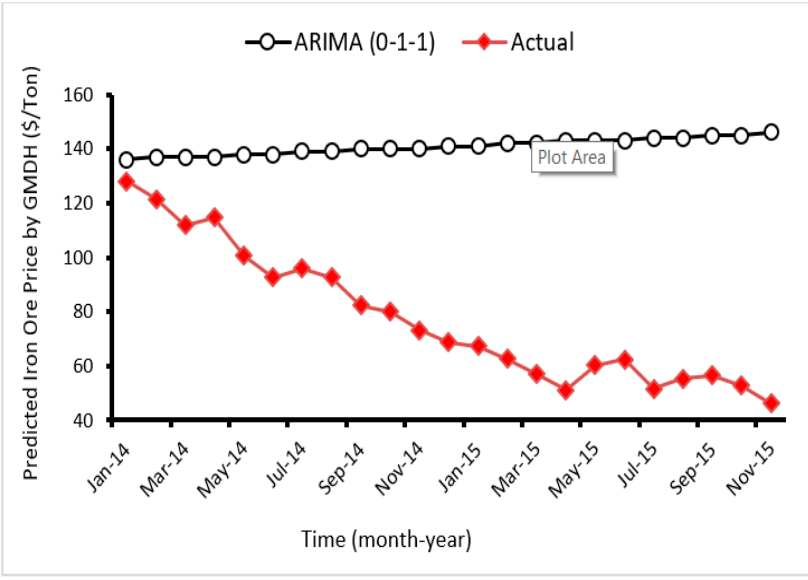
Figure 10. Comparison between the measured and the predicted by ARIMA model for test stage.